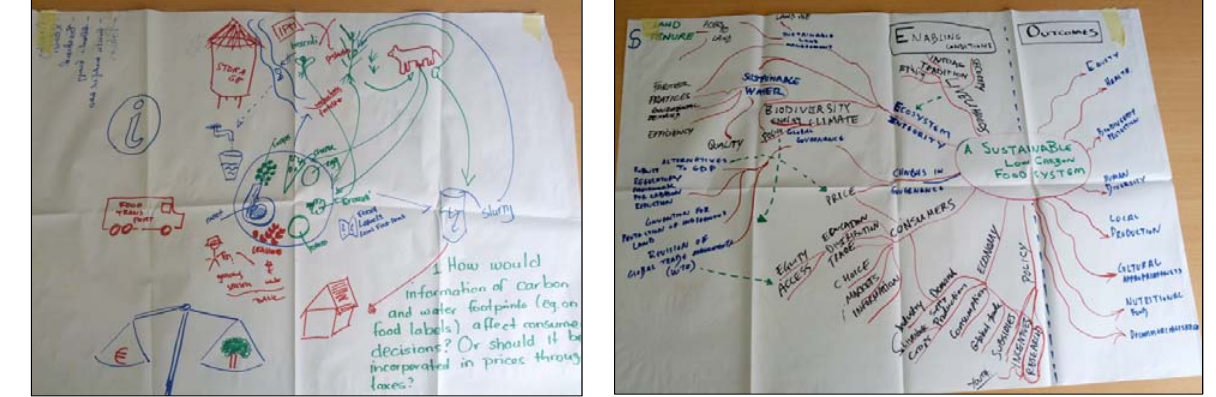
Figure 2. Examples of Diagram Outputs of the Action Research Methodologies Held at